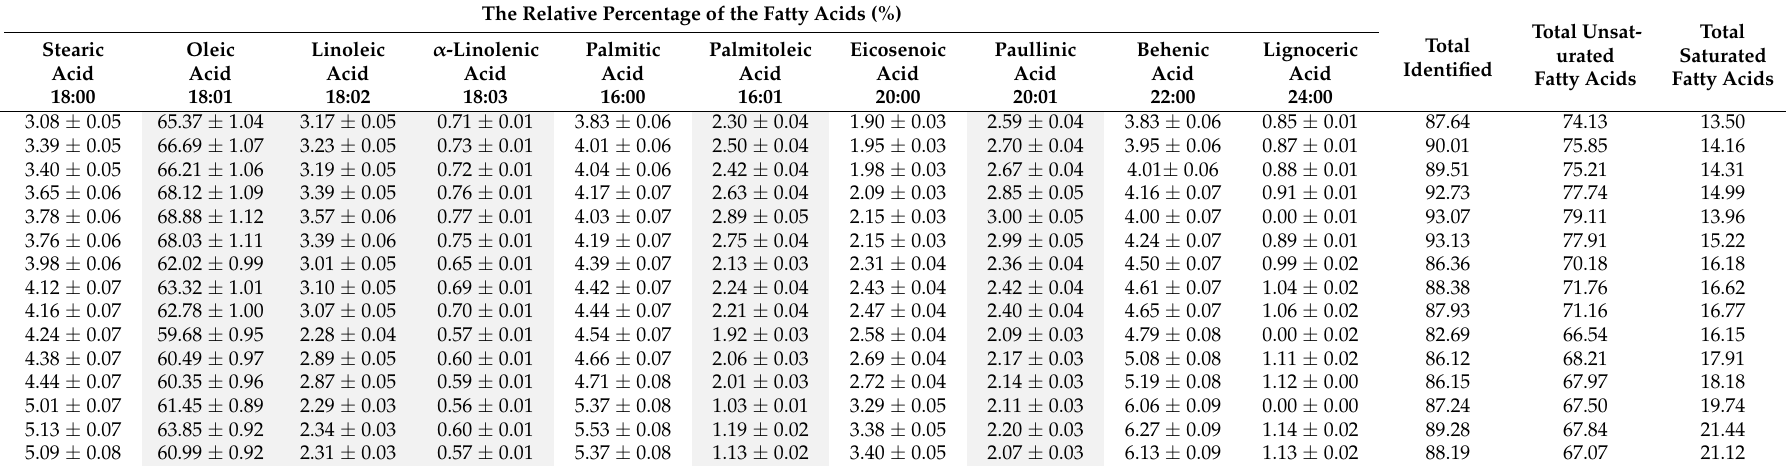
Table 3. Effect of proline (Pro) or phenylalanine (Phe) foliar applications on the chemical composition of the oil of Moringa olivera L. trees cultivated under different levels of salinity. Values are the mean of three triplicates ±